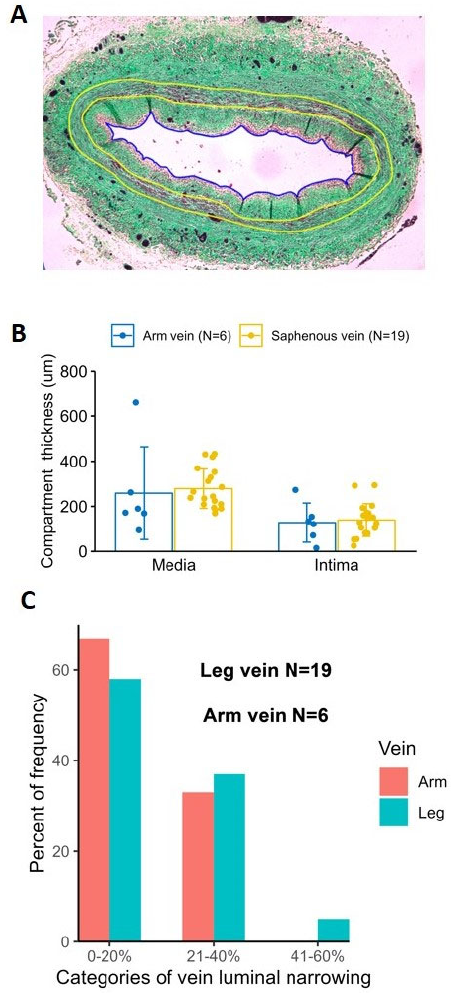
Figure 8. Human Saphenous Vein and Arm Vein Comparison. Panel ( A ) demonstrates a representa- tive histology section of a human vein. The boundaries between the intima and media (IBL) and media and adventitia (EBL) are marked with yellow lines. The picture illustrates the method for extraction of lumen perimeter (blue line) and intima and media areas that were used to calculate mean wall thickness represented in Panel ( B ) and percent lumen narrowing due to intima formation represented in Panel ( C ).